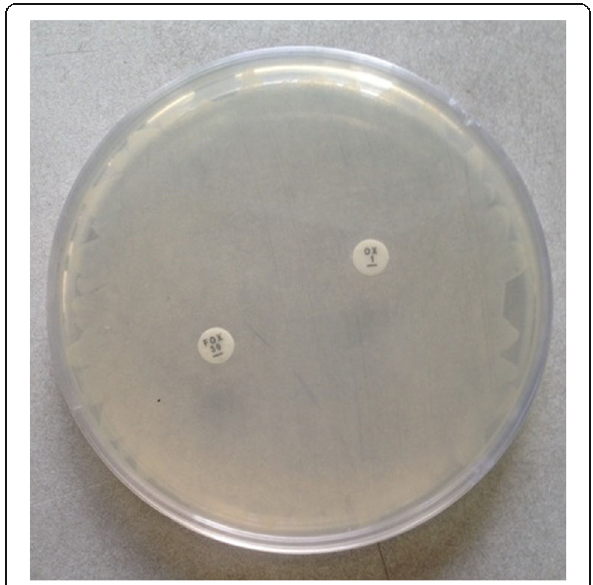
Fig. 2 Identification of MRSA. Coagulase positive S. aureus showed resistance to oxacillin (1 μ g) ≤ 12 mm and cefoxitin (30 μ g) ≤ 21 mm by disc diffusion